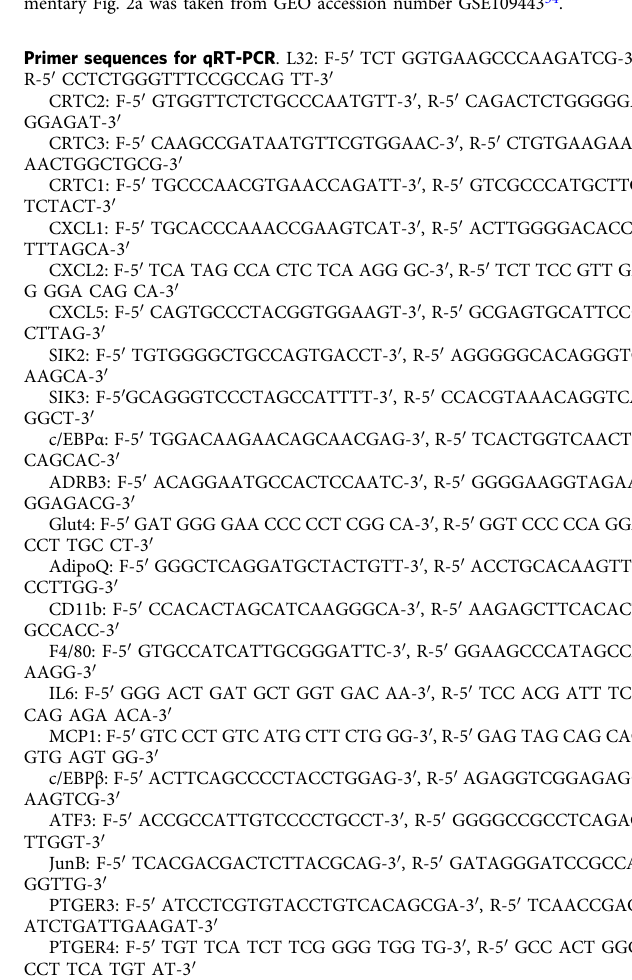
Fig. 5 Immuno-depletion of CXCL1/2 protects against HFD-induced immune cell in fi ltration into adipose tissue. a Glucose tolerance testing (1 g/kg glucose) of dAKO and WT mice injected with neutralizing antibodies against CXCL1/2 ( α -CXCL1/2) or IgG control (** or ## P < 0.01, * P < 0.05, t -test; n = 5, 5, 7 per group). Mice were fed a HFD for 9 weeks. Middle, area under curve (AUC) showing effect of dAKO and CXCL1/2 immuno-neutralization (** P < 0.01, one-way ANOVA; n = 5, 5, 7 per group). Right, Changes in body weight before and after injection of control IgG or anti-CXCL1/2 antiserum (* P < 0.05, one-way ANOVA; n = 5, 5, 7 per group). b Microscope sections of eWAT from IgG or α -CXCL1/2 injected WT mice, versus IgG injected dAKO mice under HFD feeding conditions for 9 weeks. Sections were stained using antisera against neutrophil (Ly6G) or macrophage marker (F4/80). Representative images from 5 mice per group shown. c Expression of immune-related genes in eWAT from IgG injected WT, IgG injected dAKO, and α -CXCL1/2 injected WT HFD fed mice (** P < 0.01, * P < 0.05, one-way ANOVA; n = 5, 5, 7 per group). d Immunoblots of eWAT showing effect of